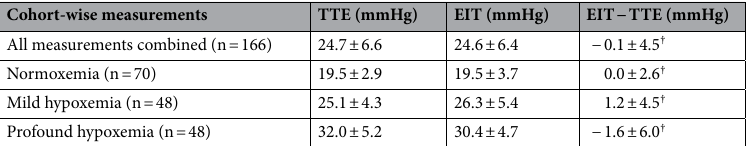
Table 2. Agreement between the EIT-derived and TTE-derived SPAP estimates at the cohort-wise level. The distributions over the entire cohort (n = 166 paired measurements) are shown as “mean ± standard deviation”. The agreement is also depicted as a function of the oxygen saturation level (SpO 2 ), comparing the distributions in normoxemia (SpO EIT electrical impedance tomography, TTE transthoracic echocardiography, SPAP systolic pulmonary artery pressure. † Paired-sample t -test: Not significant at the 5% significance level ( P > 0.05).